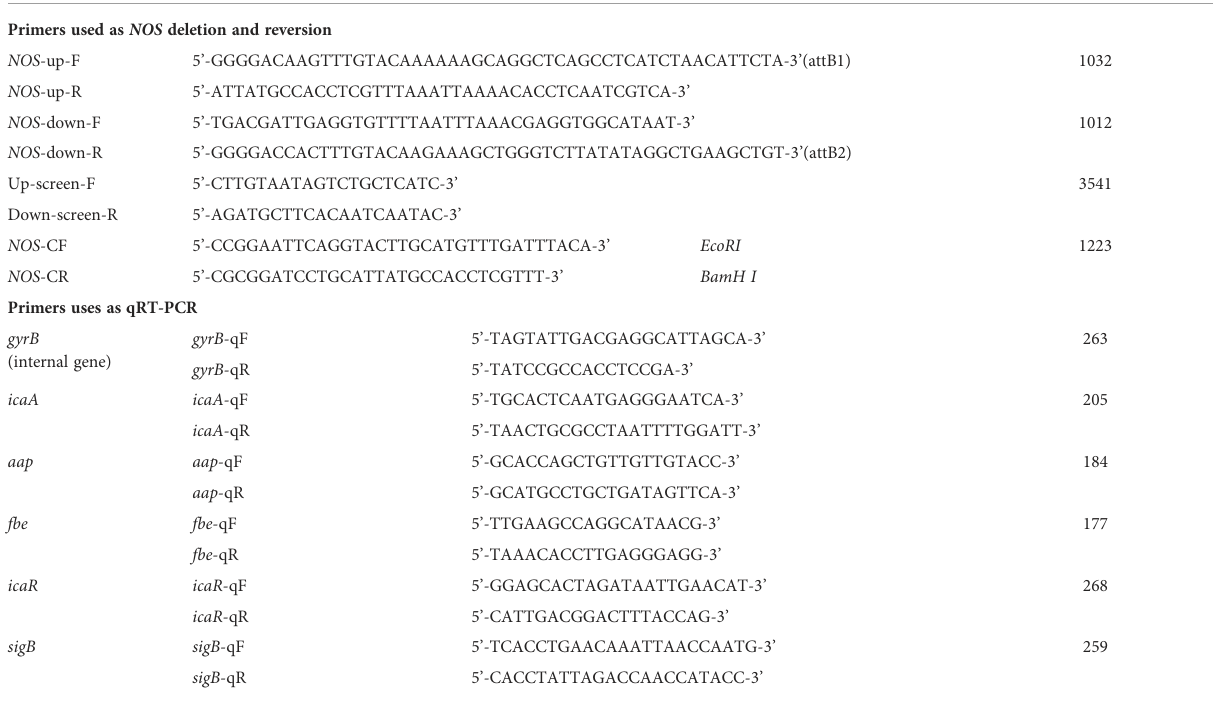
TABLE 1 Primer sequences used in this